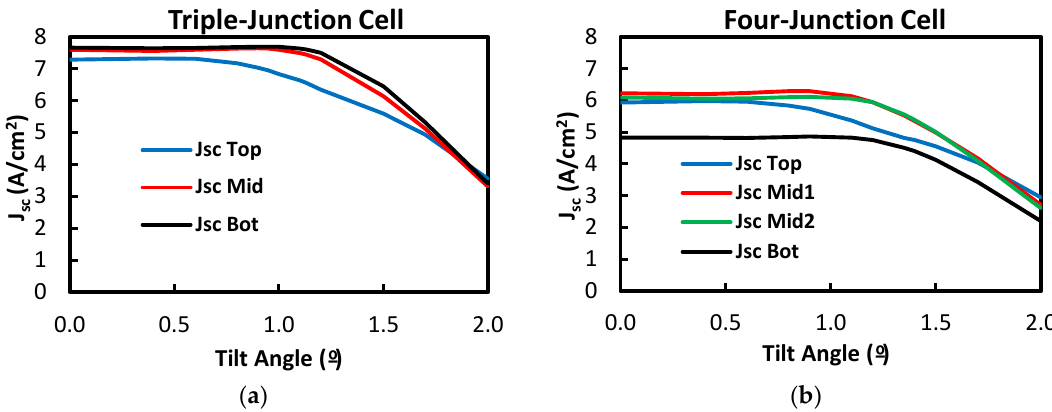
Figure 3 . ( a ) simulated short-circuit current density of the subcells of the unit equipped with the triple-junction solar cell under different tilt angles of the light [13]; ( b ) analogous with the four-junction solar cell.